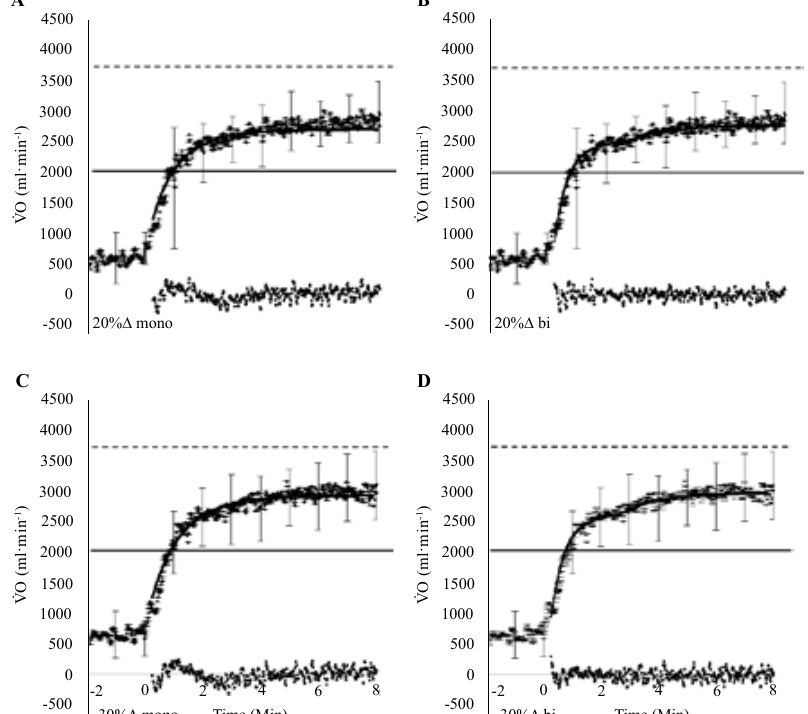
Figure 3. The breath-by-breath oxygen uptake response, mono and bi exponential model fits and residuals across exercise intensity domains in one typical participant. Data from the exercise performed at +20%∆ and +30%∆ are displayed. The V̇ O